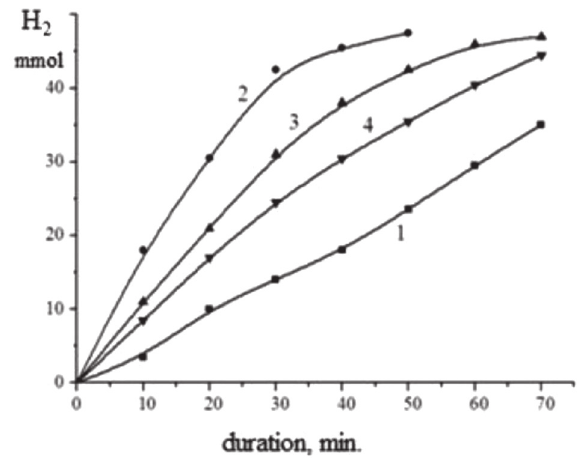
Fig. 3 – Hydrogenation of benzene fraction “hydrogenate” pos.11-SN-002 KU GBD in hexane at 3.0 MPa and 298 K; 1 – Rh/Al O , 2 – Pt-Pd (1:1)/Al 2 3